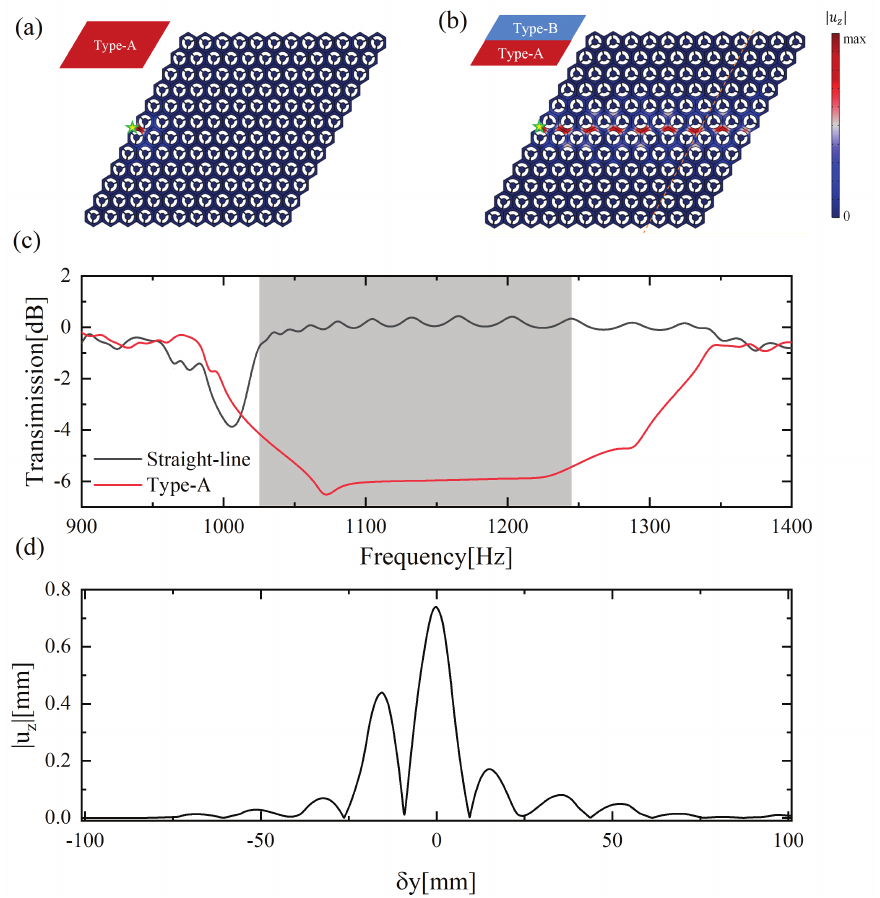
Figure 5. Intensity distribution of the displacement field and transmission spectrum under the out-of-plane harmonic excitation of 1133.5 Hz: ( a ) displacement field distribution of the traditional Type-A waveguide composed of entirely A-type cells, where the star denotes the excited position; ( b ) displacement field distribution of the straight-line channel topological waveguide; ( c ) transmission curves of the Type-A and straight-line waveguide; ( d ) intensity distribution of displacement | u z | associated with the orange line range in ( b